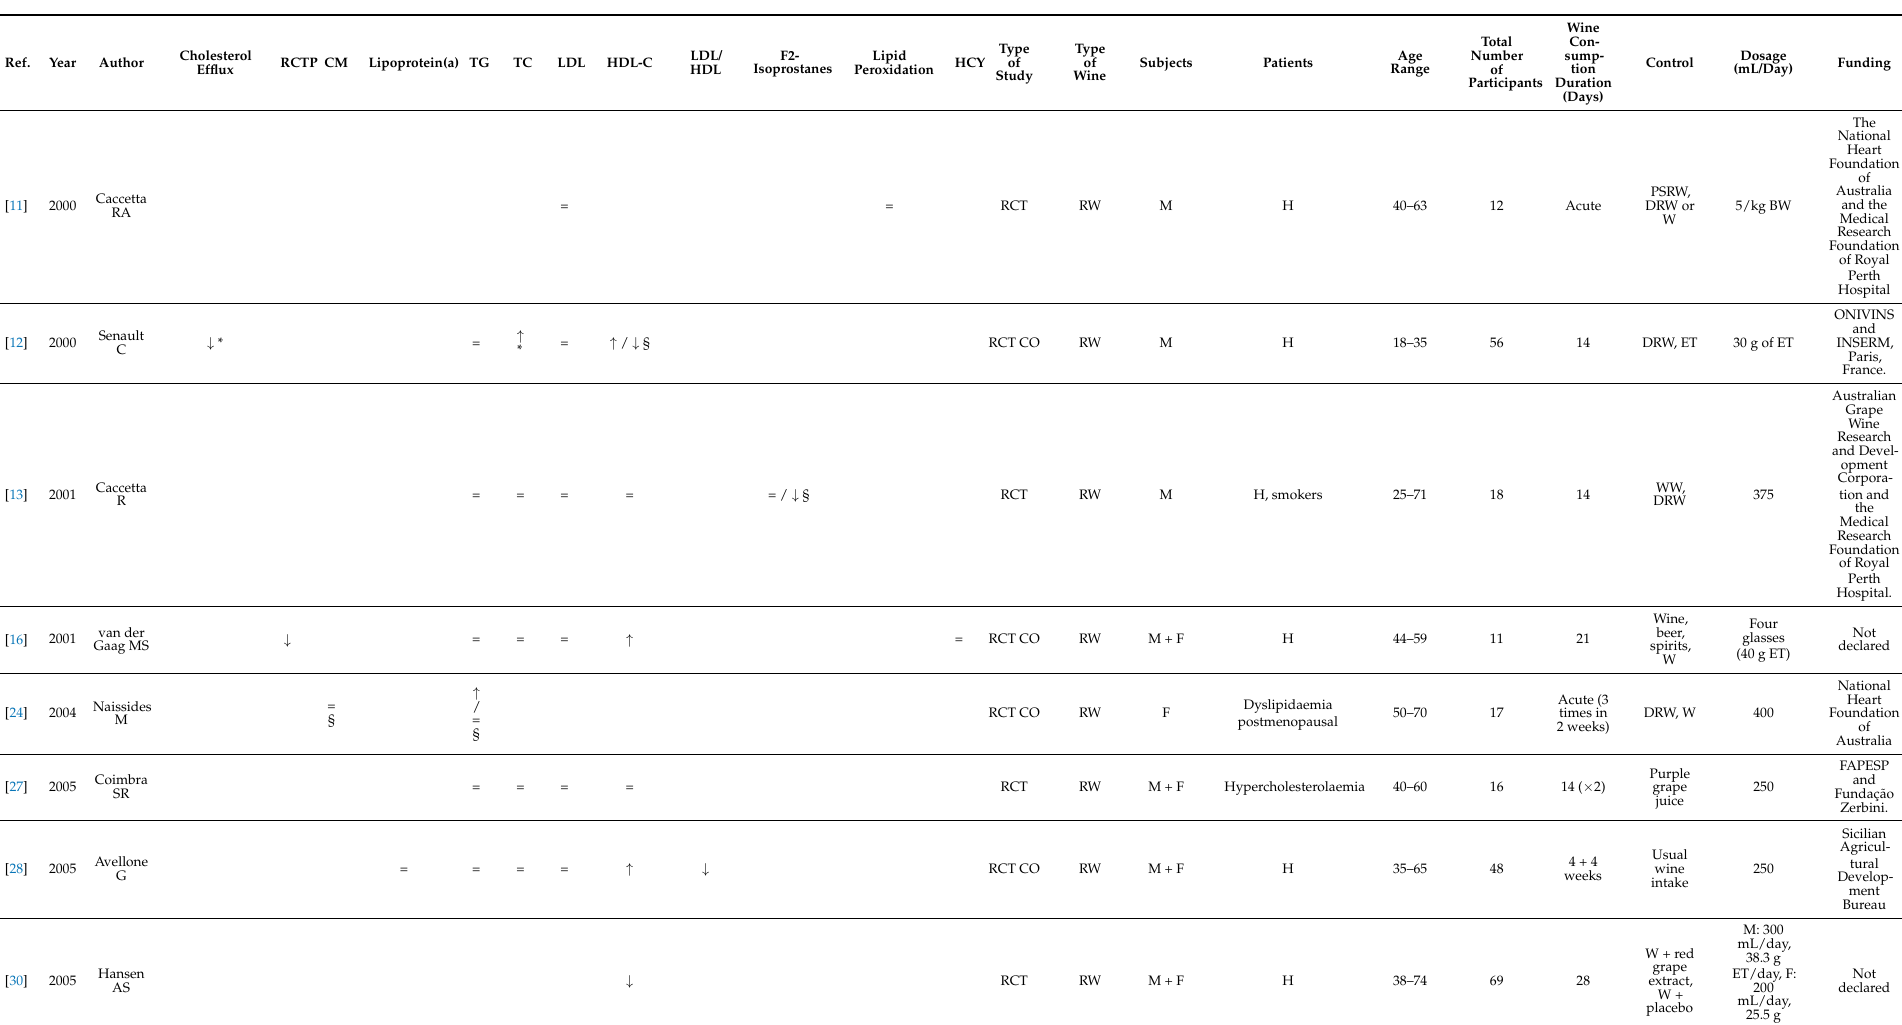
Table 7. Effects of red wine consumption on lipid profile and homocysteine